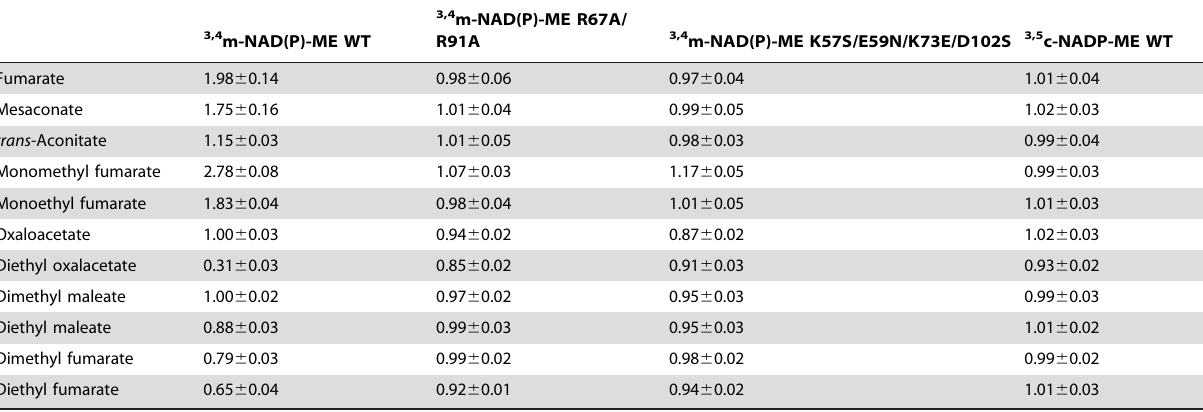
Table 1. Effect of fumarate analogs on human m-NAD(P)-ME and c-NADP-ME 1,2